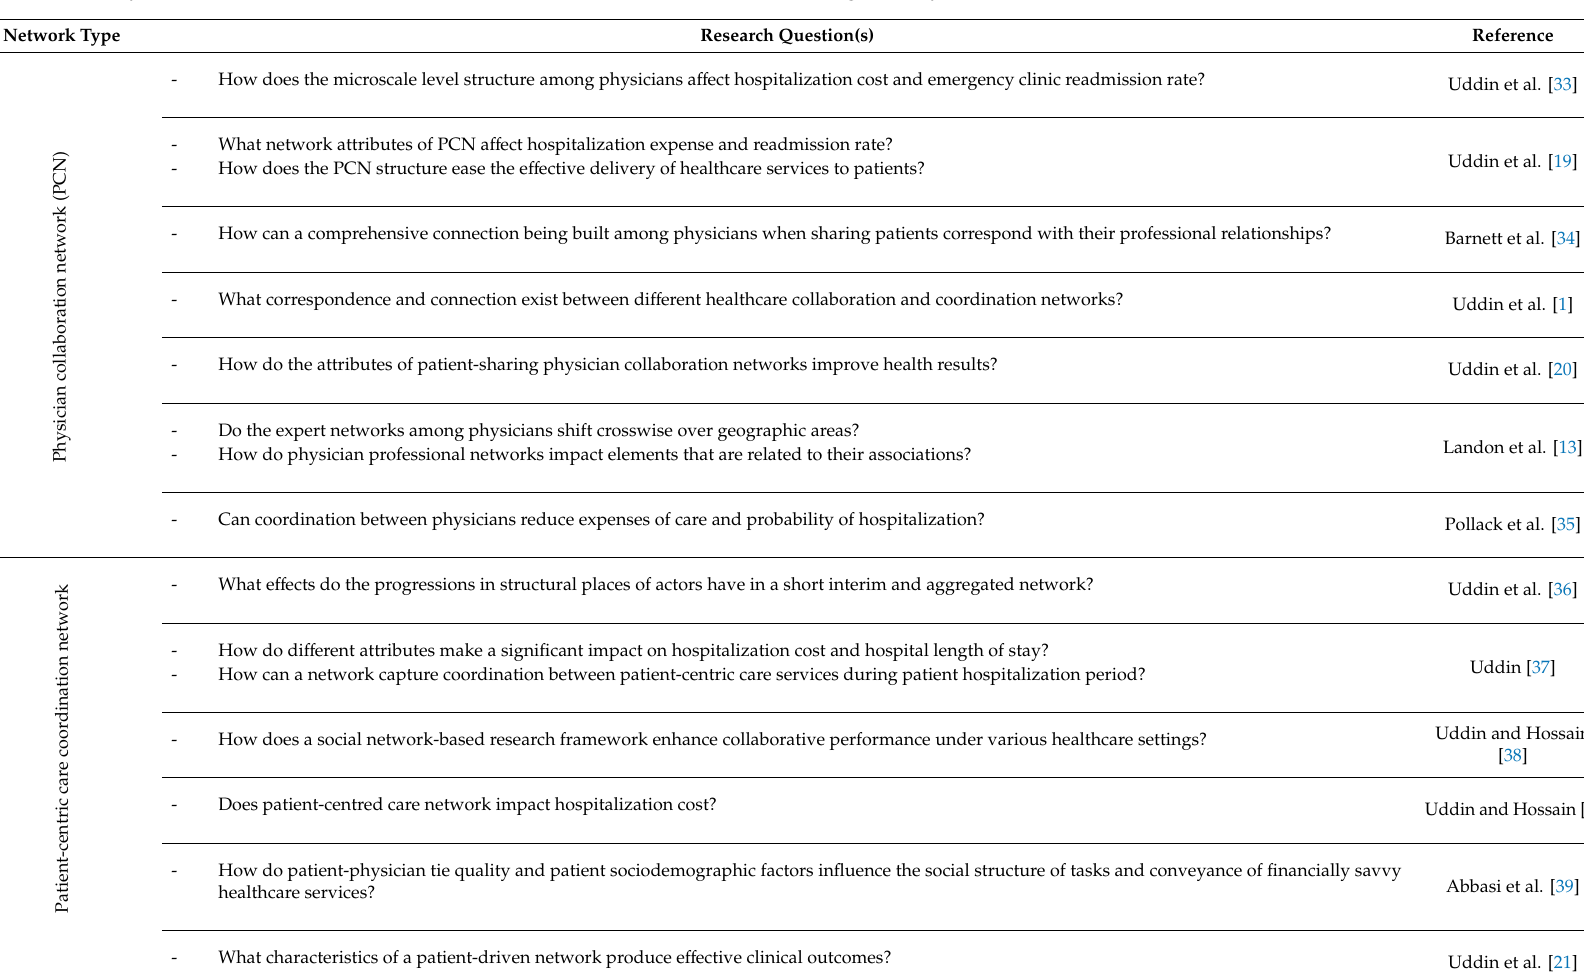
Table 2. List of studies that focus on networks using administrative health data. This study considers only those study that used administrative health data to conduct a network study in a healthcare context. Network studies based on other health data (e.g., survey data) have been excluded. Network